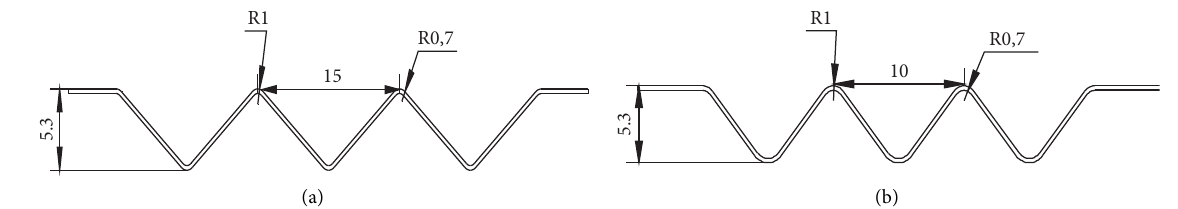
Figure 5: Structure size of corrugated samples. (a) Large pitch. (b) Small pitch.